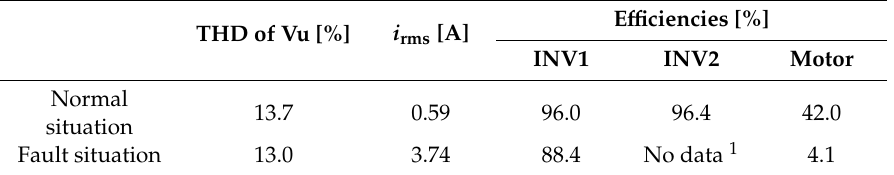
Table 3. Measurement